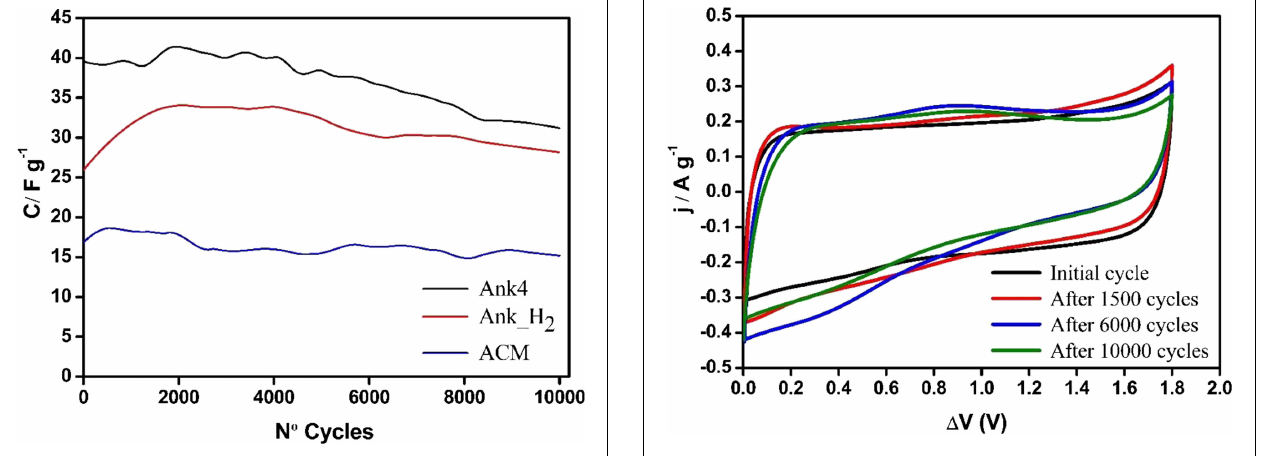
Regarding the coulombic efficiency, the three